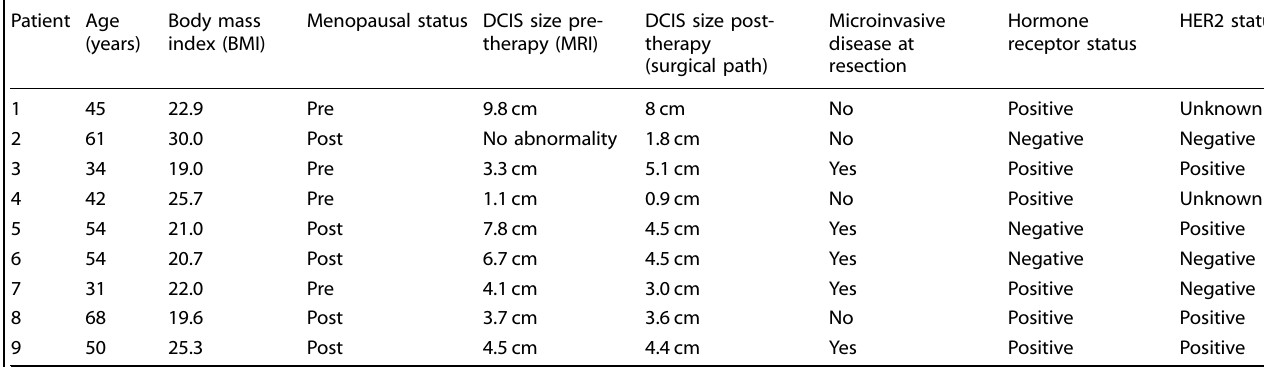
Table 1. Clinical characteristics of the patient